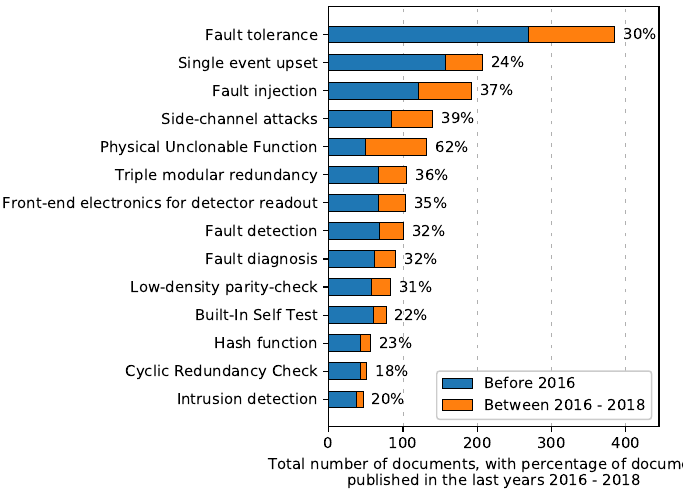
Figure 7. Security top applications in FPGA